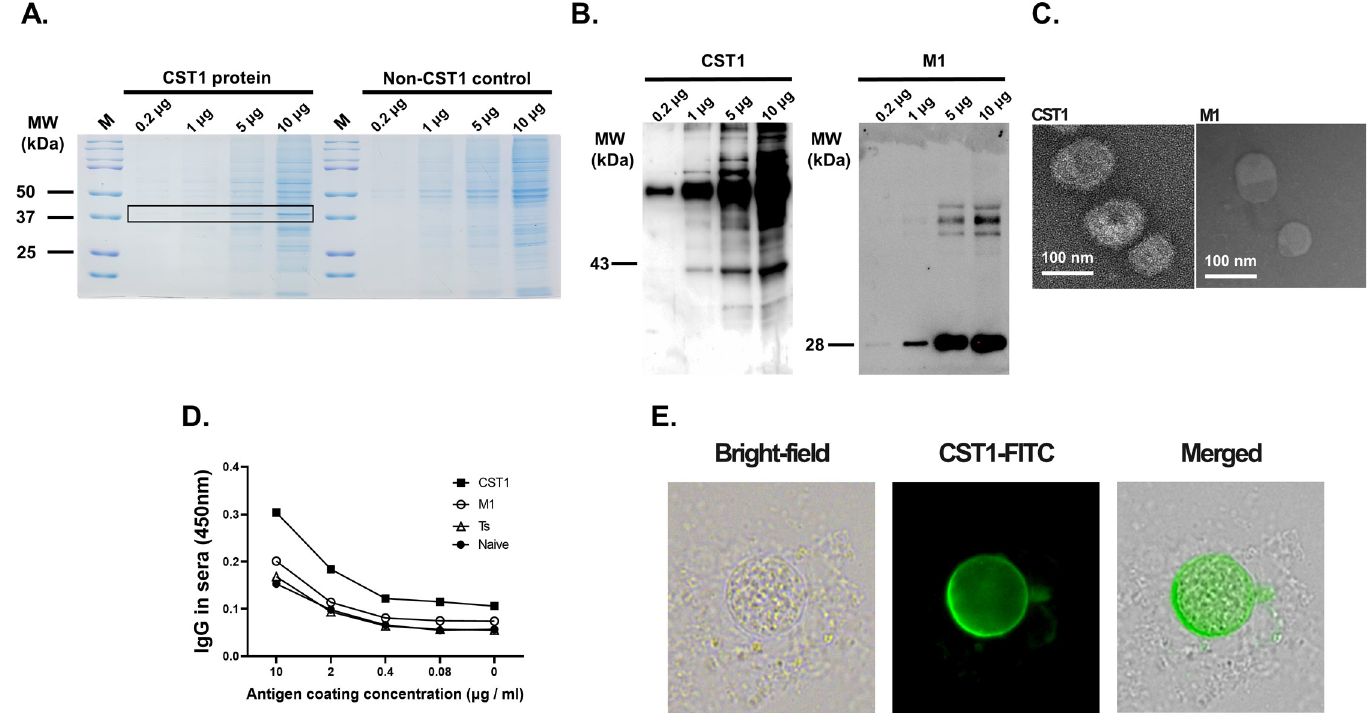
Fig 2. VLPs characterization and immunofluorescence assay. (A) SDS-PAGE was performed using the whole lysates of Sf9 cells which were either infected or uninfected with the CST1-rBVs. Gels were stained with the Coomassie blue dye to identify CST1 protein expression and its separation. The boxed region corresponds to CST1 which has a molecular weight of 43 kDa. (B) Antigen components of the VLPs were characterized using western blot after probing the membranes with polyclonal mouse anti- T . gondii sera and anti-M1 monoclonal antibody. (C) Morphologies of the purified VLPs and the vehicle control (M1 VLP), which do not express the CST1 gene were examined by transmission electron microscopy. (D) Serum antibody responses against serially diluted concentrations of T . gondii ME49 were evaluated by ELISA (Ts: T . spiralis infection sera, M1: M1 VLP immune sera). (E) Immunofluorescence assays were performed to assess whether the polyclonal sera acquired from T . gondii -infected mice could interact with the CST1 antigens. Images were acquired at 400x magnification under a fluorescent microscope.